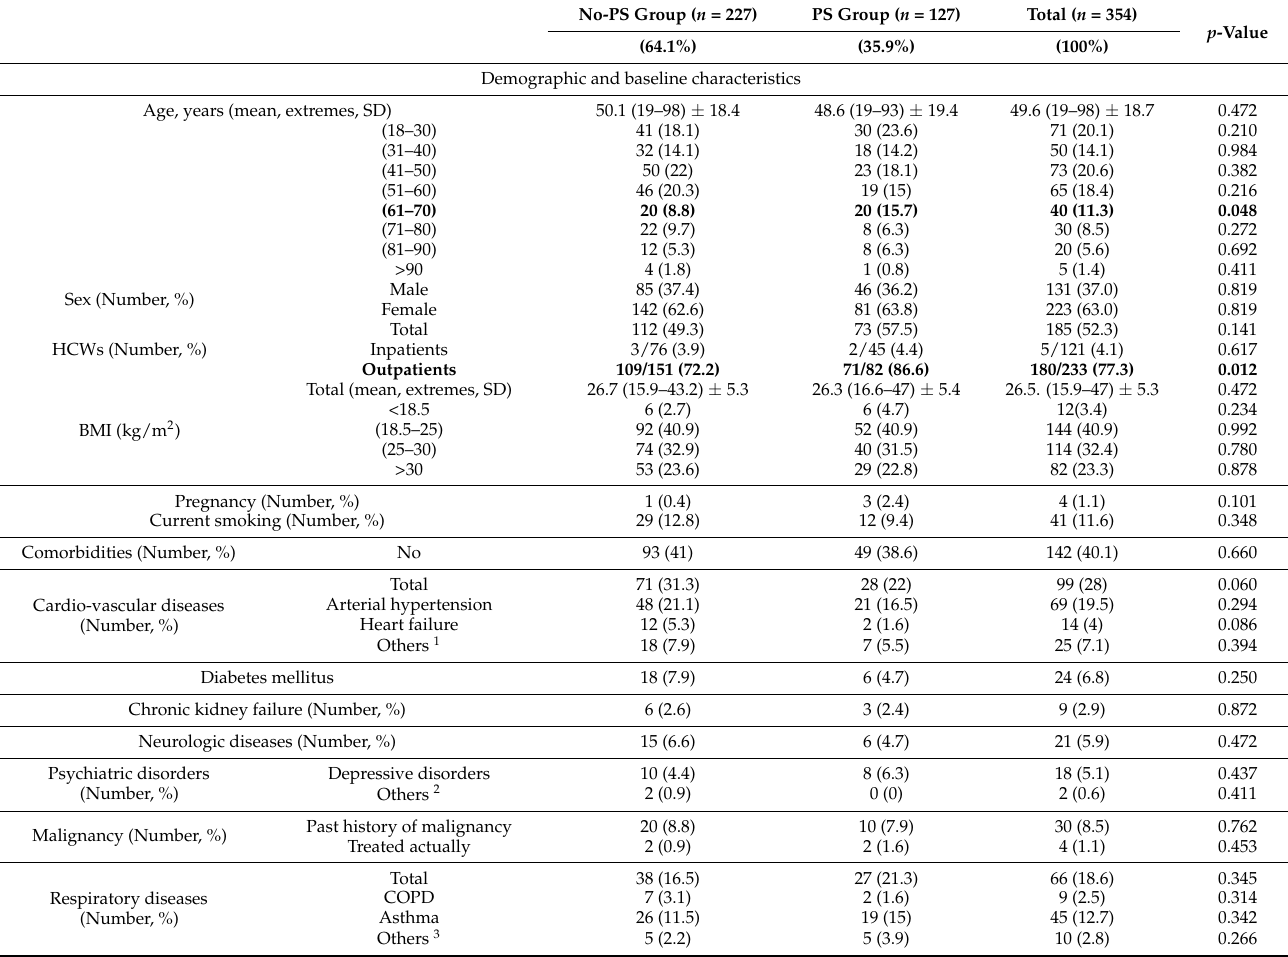
Table 1. Demographic, clinical characteristics, laboratory, and imaging findings in 354 COVID-19 patients with or without persistent symptoms after SARS-CoV-2 infection, Nord Franche-Comte Hospital, France . No-PS Group ( n = 227) PS Group ( n =